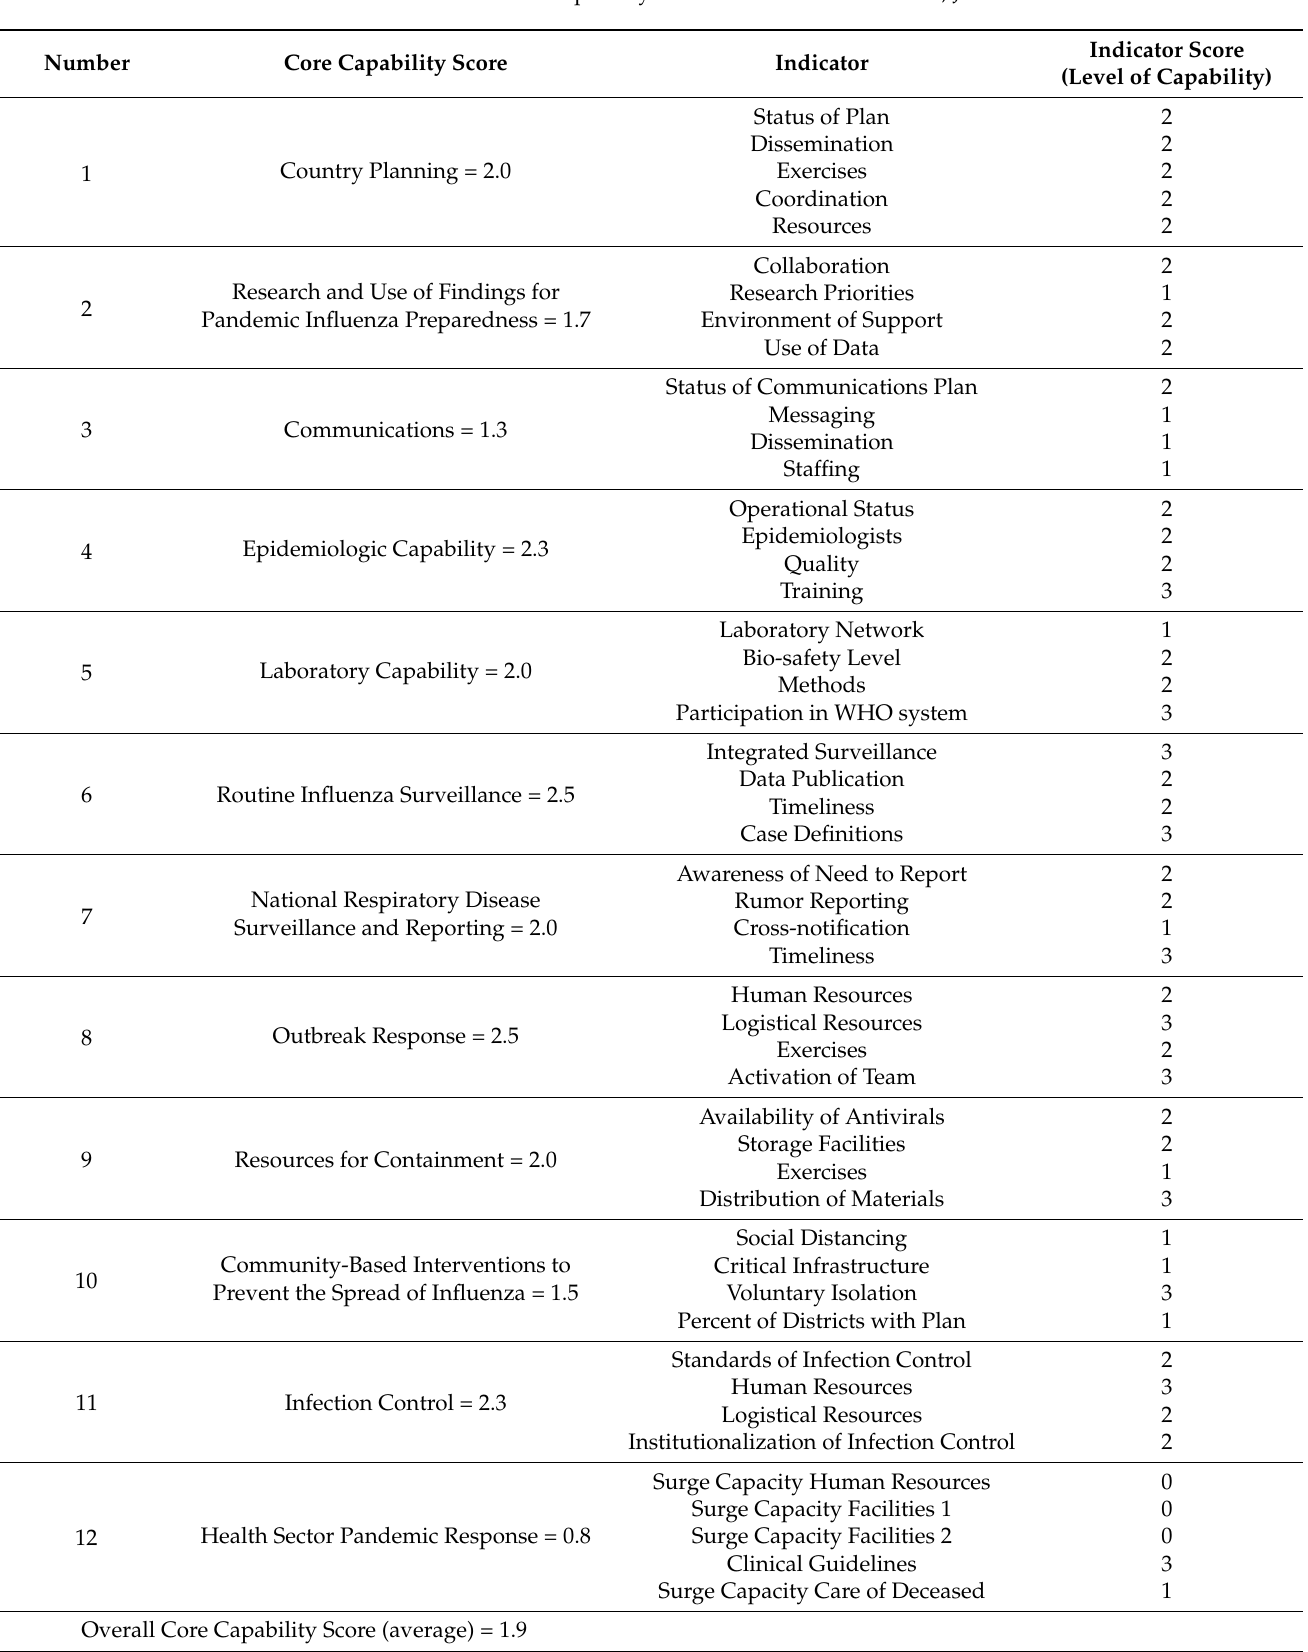
Table 2. Influenza core capability indicators’ matrix and scores, Jordan